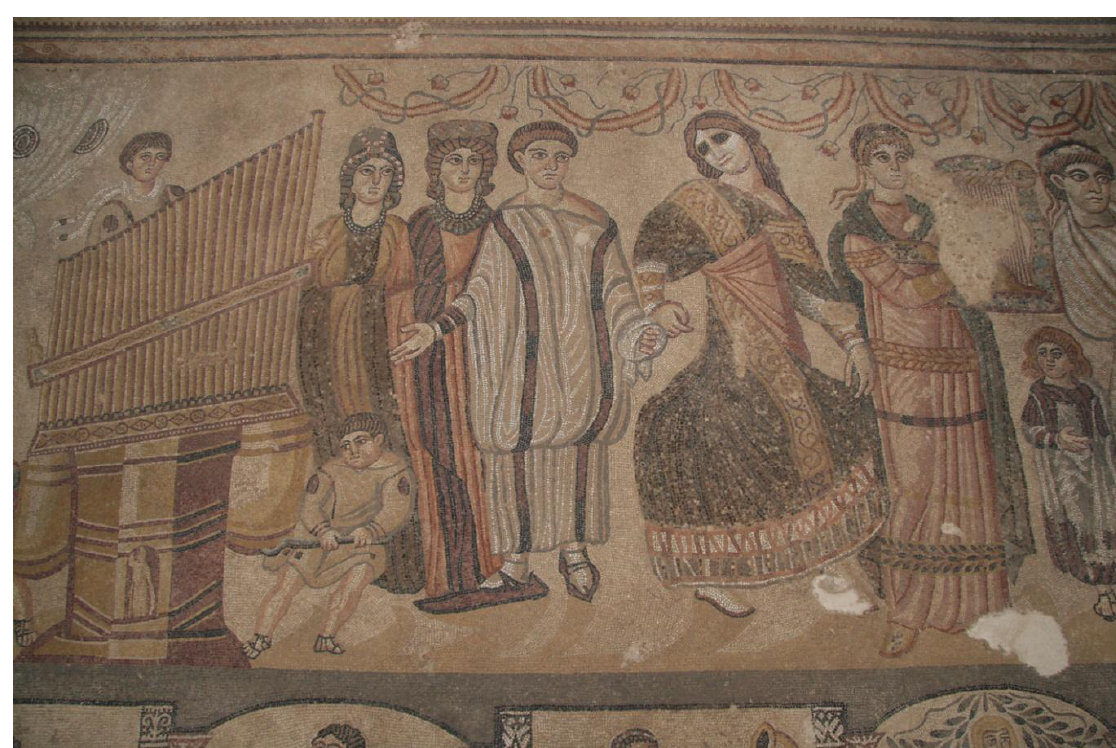
Figure 2. Mosaic